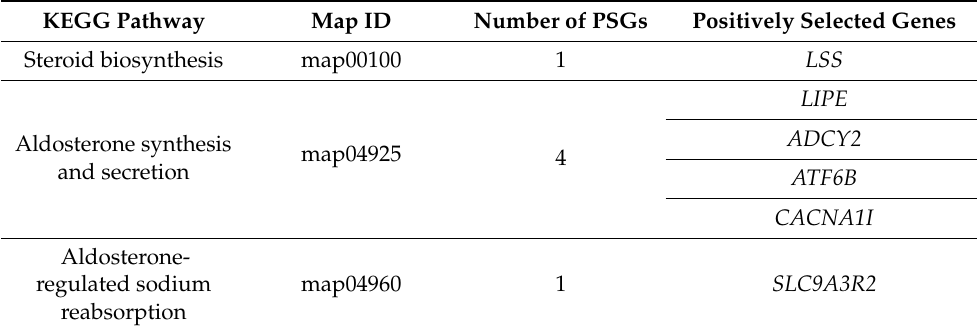
Table 1. PSGs in KEGG pathways related to ambergris production.